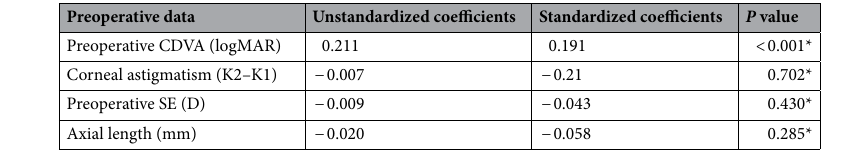
Table 4. Linear regression analysis of postoperative absolute refractive error and preoperative data. CDVA, corrected distance visual acuity; SE, manifest spherical equivalent. *Simple linear regression analysis.